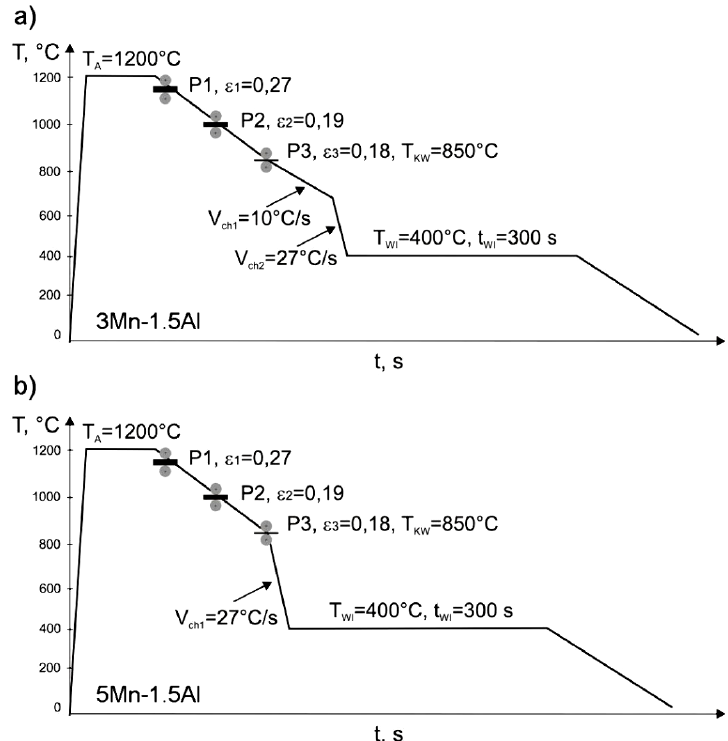
Figure 1. Parameters of thermomechanical processing of ( a ) 3Mn-1.5Al steel and ( b ) 5Mn-1.5Al steel ( T KW — finish rolling temperature).